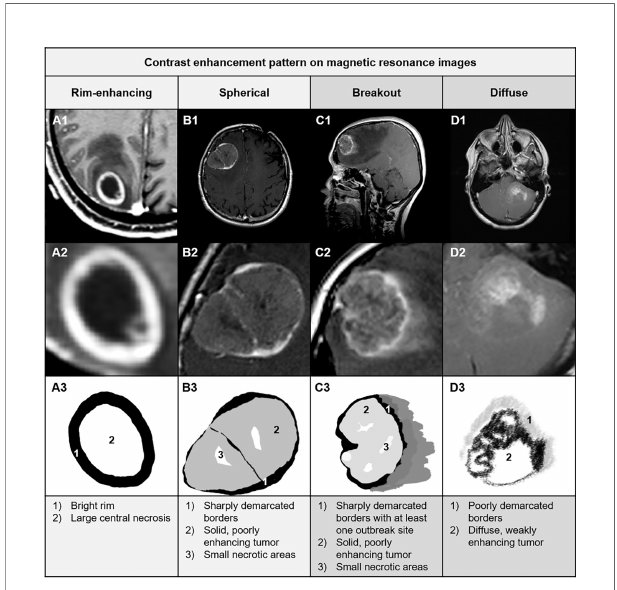
FIGURE 1 | De fi nition, examples (A1 – D1) and description (A2 – D2) of the four different MRI subtypes: (A) rim-enhancing, (B) spherical, (C) breakout, and (D)